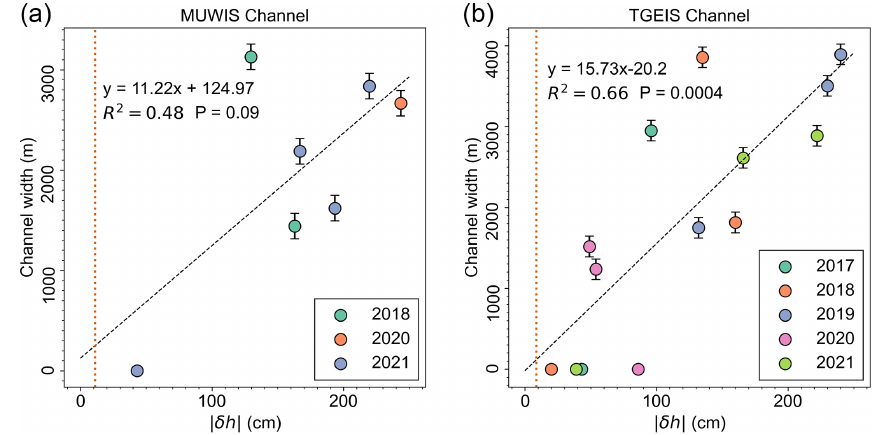
Figure 10. (a) Comparison between the absolute differential tidal predictions | δh | from the CATS2008 tidal model and the width of Moscow University Western Ice Shelf (MUWIS) ocean channel (Table S6). Year acquisition of DInSAR data is colour-coded; the channel width is measured using the reference line shown as the red line in Fig. 8a. (b) Comparison between the absolute differential tidal predictions | δh | using the CATS2008 tidal model and the width of the Totten Glacier Eastern Ice Shelf (TGEIS) ocean channel (Table S7). The year acquisition of DInSAR data is colour-coded; the channel width is measured using the reference line shown as the red line in Fig. 9a. The locations of tidal prediction reference points at both regions are shown in Fig. S7. In both subplots, the vertical orange dotted lines denote the absolute differential tidal predictions from the CATS2008 tidal model at the time of the satellite image passes used in the MEaSUREs 1996 ERS-1/2 DInSAR GL measurements (Rignot et al., 2011, 2016) (Table S2).